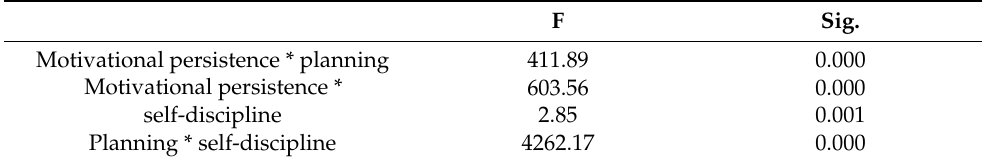
Table 5. Multivariate tests for the psychological